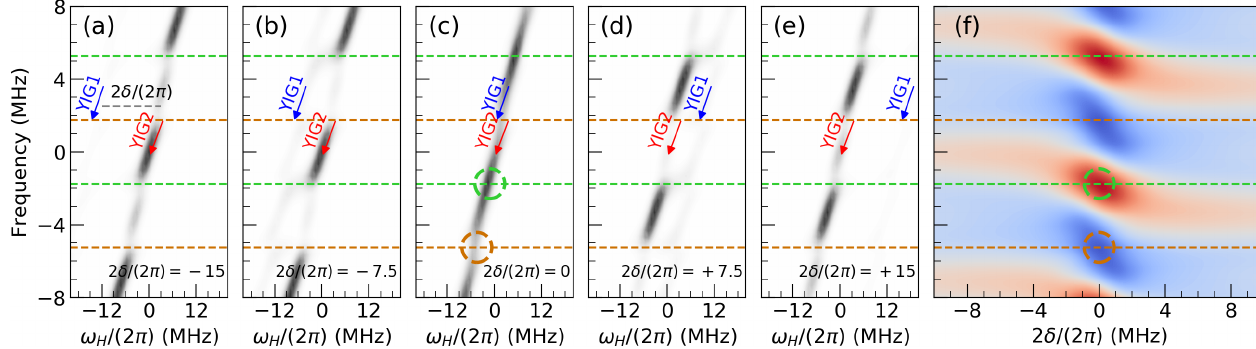
FIG. 5. (a) – (e) Numerically calculated intensity P 2 ð ω Þ plotted for different detunings δ between top and bottom Kittel resonance frequencies (parameters given in the text). The abscissa ω H ¼ γ H corresponds to a field sweep inducing a shift of the two Kittel modes along the resonance condition, while the even (orange dashed line) or odd (green dashed line) phonons do not depend on the field (horizontal lines). The gray scale indicates the calculated power dissipated by m 2 . (f) Calculated dependence of the maximum signal as a function of the frequency and the frequency difference 2 δ = ð 2 π Þ .